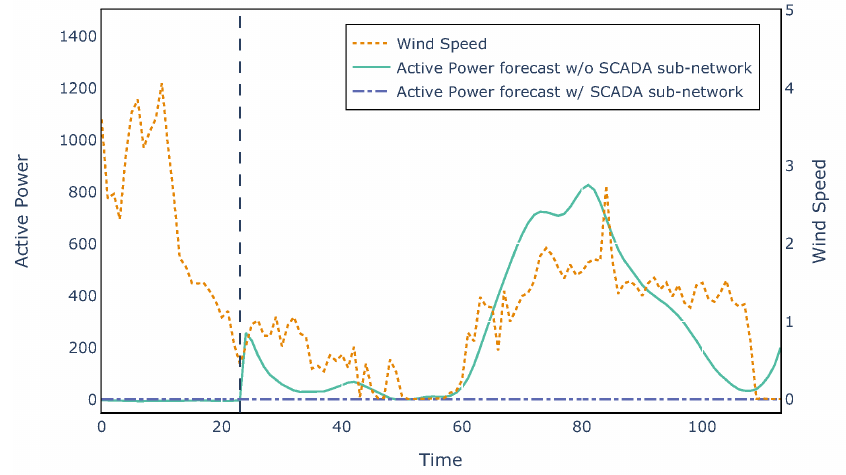
Figure 11. Wind power forecast produced by the spatio-temporal neural network for turbine R80721 in a downtime scenario, namely when the turbine is shut down and produces no power. The plot shows both the forecast produced by the model trained without considering the turbine operational conditions and the output of the neural network when trained using the SCADA data and sub- network. The x-axis ranges from 0 to 114 and includes the observed history of measurements (0–23) and the 90 forecast lead times (24–113), separated by a vertical dashed